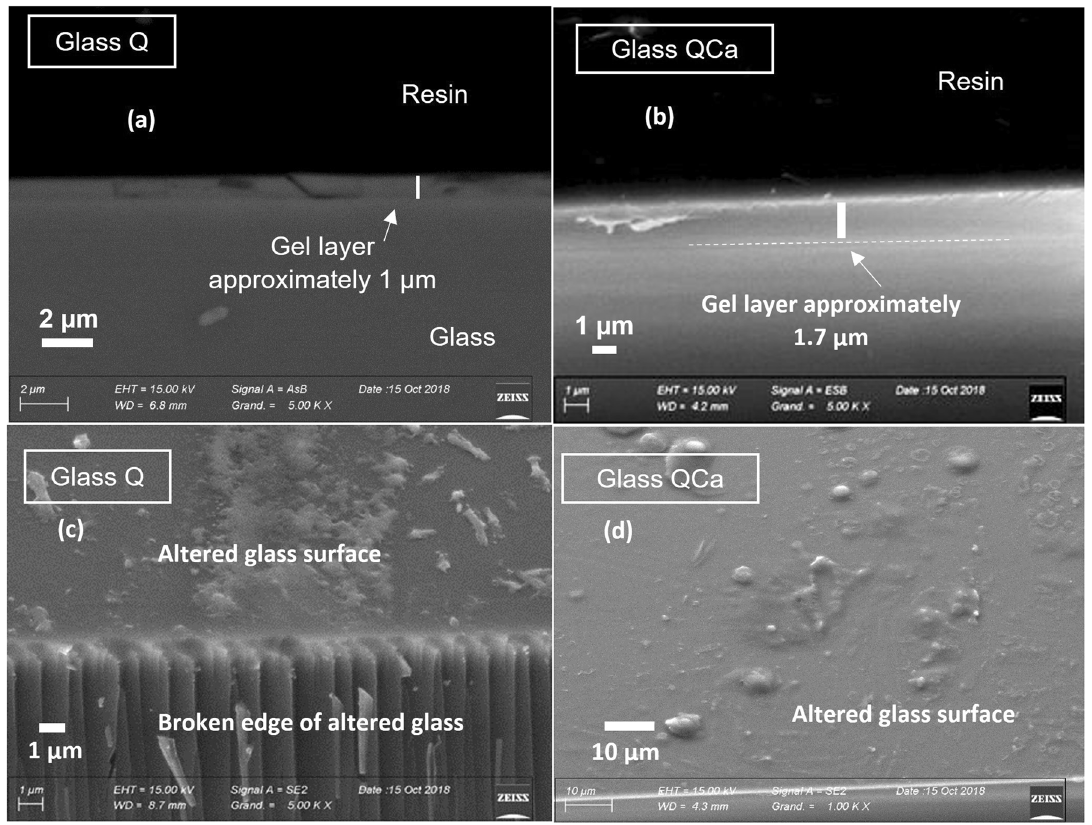
Fig. 2 SEM images of glasses altered in vapor phase. SEM images of Q (left) and QCa (right) glass altered in vapor phase (experiment no. 6 and 8, respectively, in Table 1); a cross-section BSE image of vapor-hydrated glass Q; b cross-section BSE image of vapor-hydrated glass QCa; c SE image of direct observation of vapor-hydrated glass Q surface; d SE Image of direct observation of vapor-hydrated QCa glass